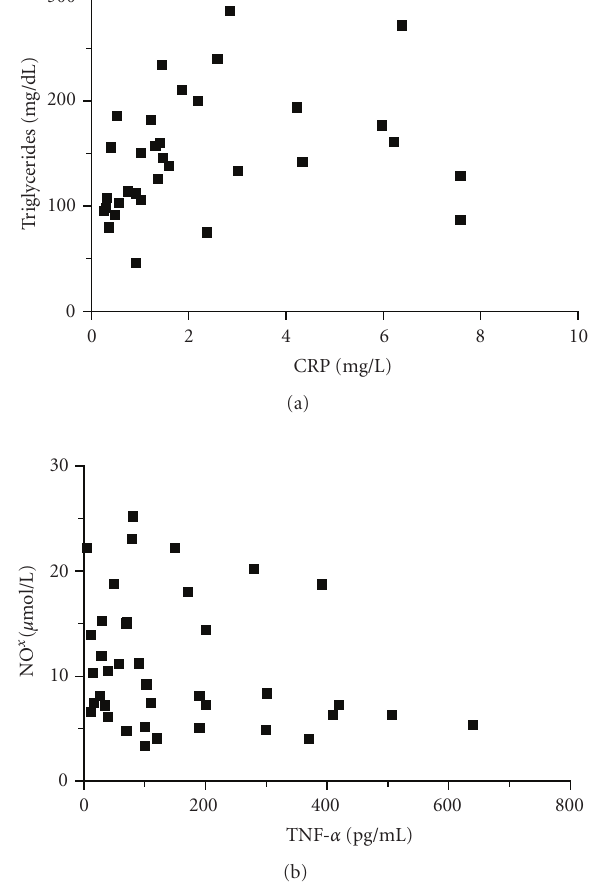
Figure 3: (a) Correlation between the concentrations of CRP and triglycerides in diabetic patients; r = . 45 and p < . 01. (b) Correla- tion between the concentrations of TNF- α and NO x in the diabetic patients; r = − . 3 and p < . 05. Each individual value is represented by a symbol ( (cid:2) ). r = Spearman’s rank correlation coe ffi